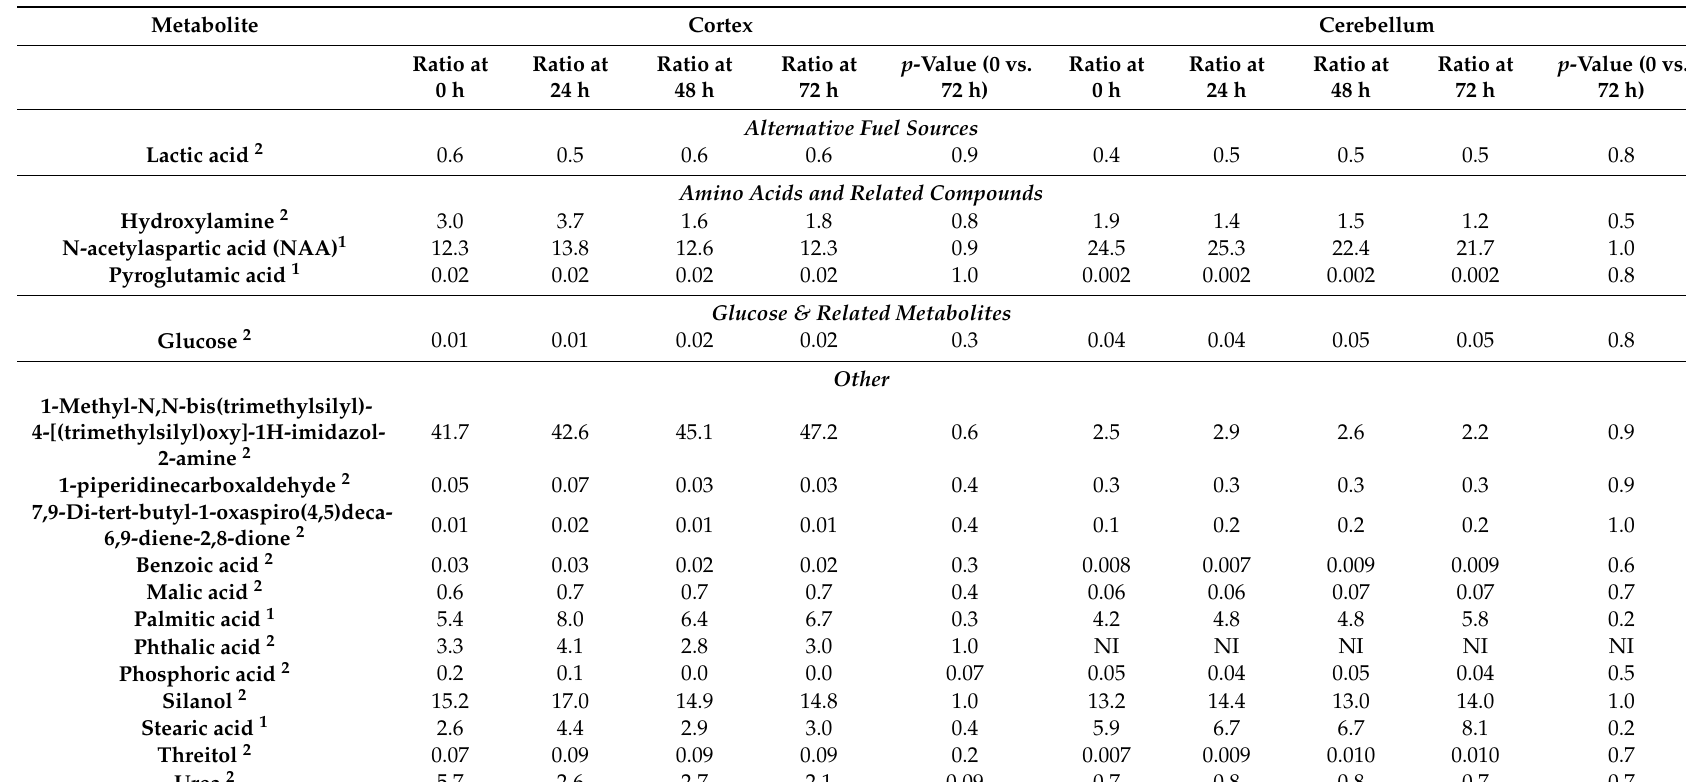
Table 2. Unaltered Metabolites in Rat Brain